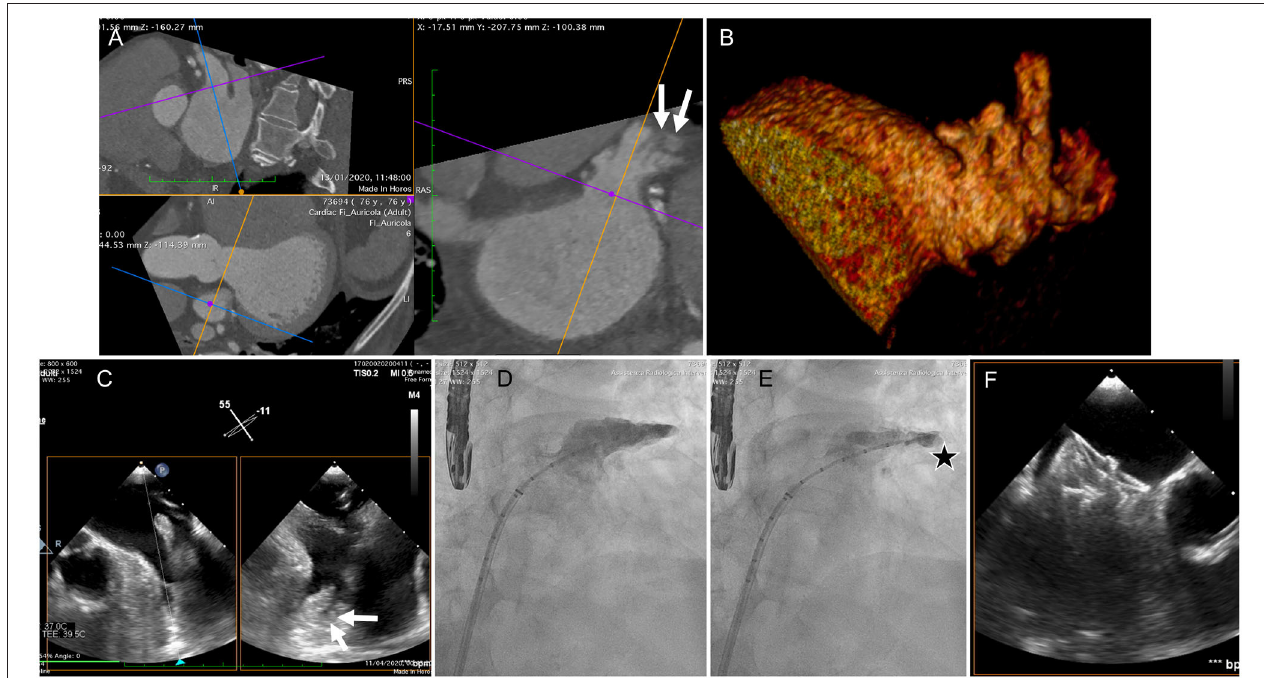
FIGURE 2 | (A) CT scan of the LAA. Proximally the LAA presented a single lobe with oval-shaped ostium while distally it divided into multiple lobes, favoring blood stagnation (arrows), configuring a cactus morphology (B) . (C) Transesophageal echocardiography, performed intraprocedurally revealed a “plus” image in the distal part of the appendage (arrows). (D) selective angiography revealed stagnation of dye in the distal lobe, with a slow wash out ( E – star). (F) Final result after successful LAA occlusion with implantation of a 25mm Amplatzer Amulet device (Abbott, Chicago, IL,